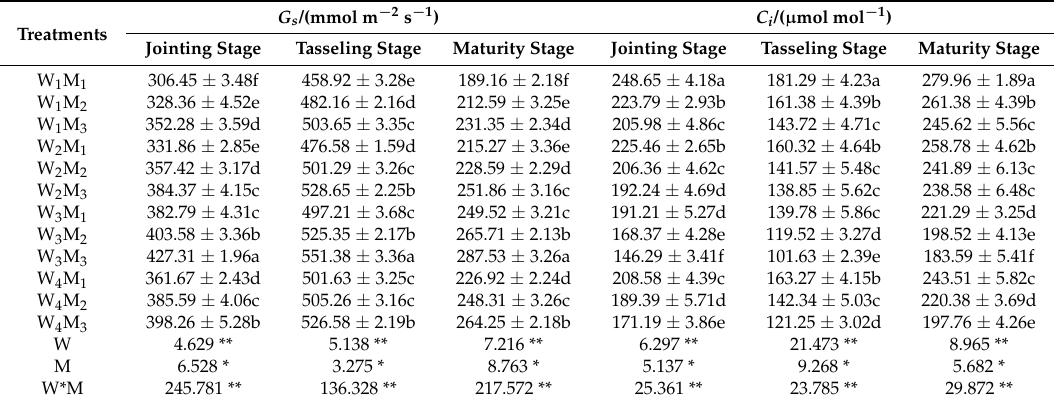
Table 3. Effect of irrigation amount on G s and C i of degradable film-covered drip-irrigated maize.